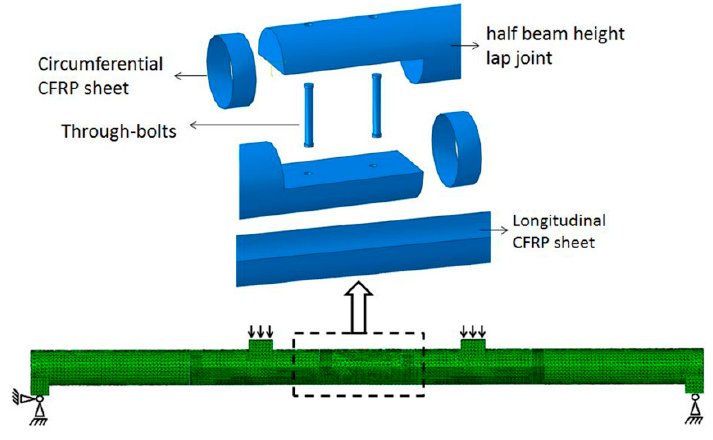
Figure 6. Numerical model of spliced beam with lap joint reinforced by CFRP sheets. Table 6. Material properties for spliced beams in numerical model [39,40].